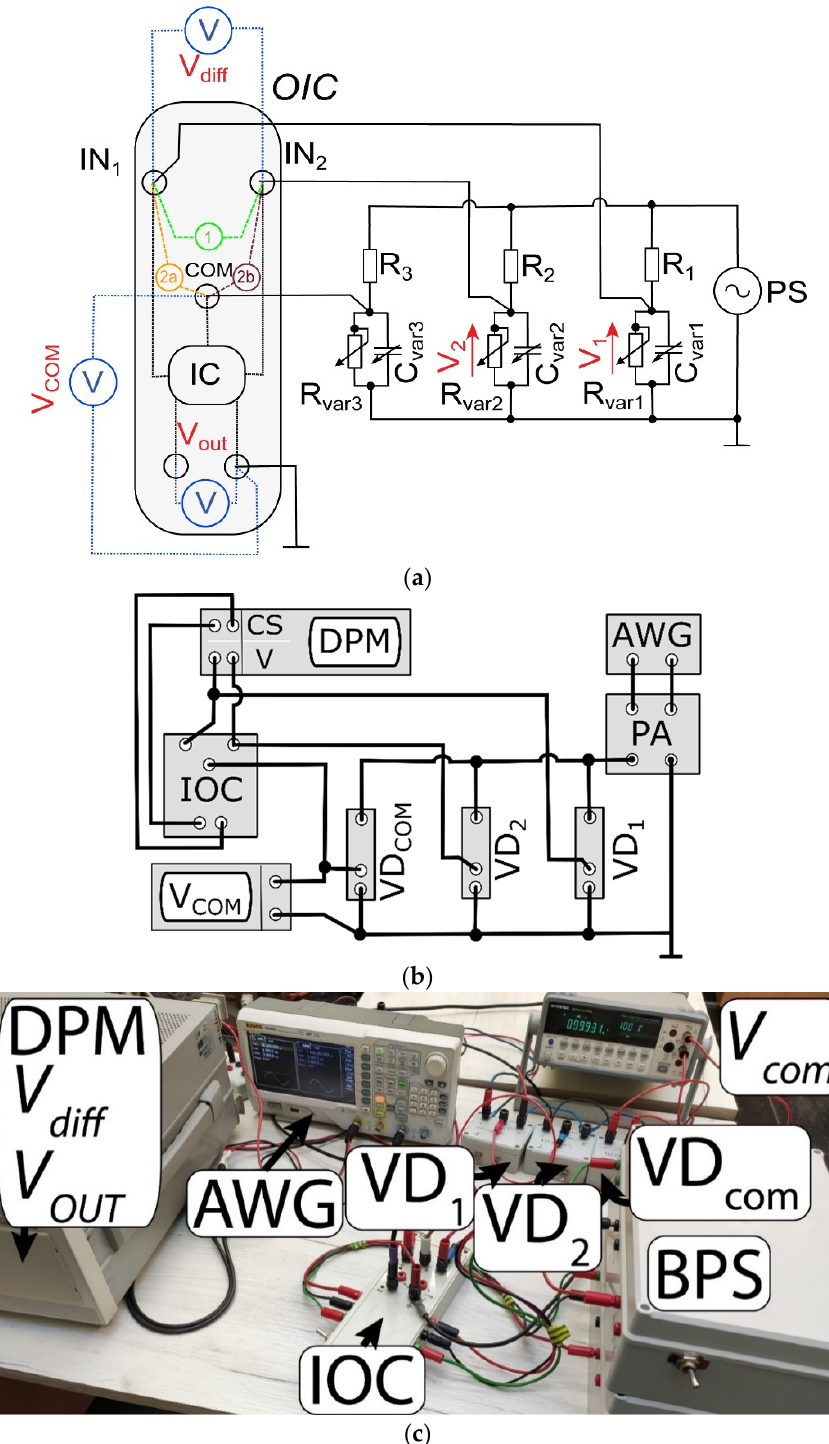
Figure 1. ( a ) Connections diagram of the two channel opto-isolation circuit during its tests. ( b ) Blocks diagram of the measuring setup for testing the two channel opto-isolation circuit. ( c ) Photo of the measuring setup for testing the two channel opto-isolation circuit. Connection 1 presented in Figure 1a is used only during the conversion accuracy tests.